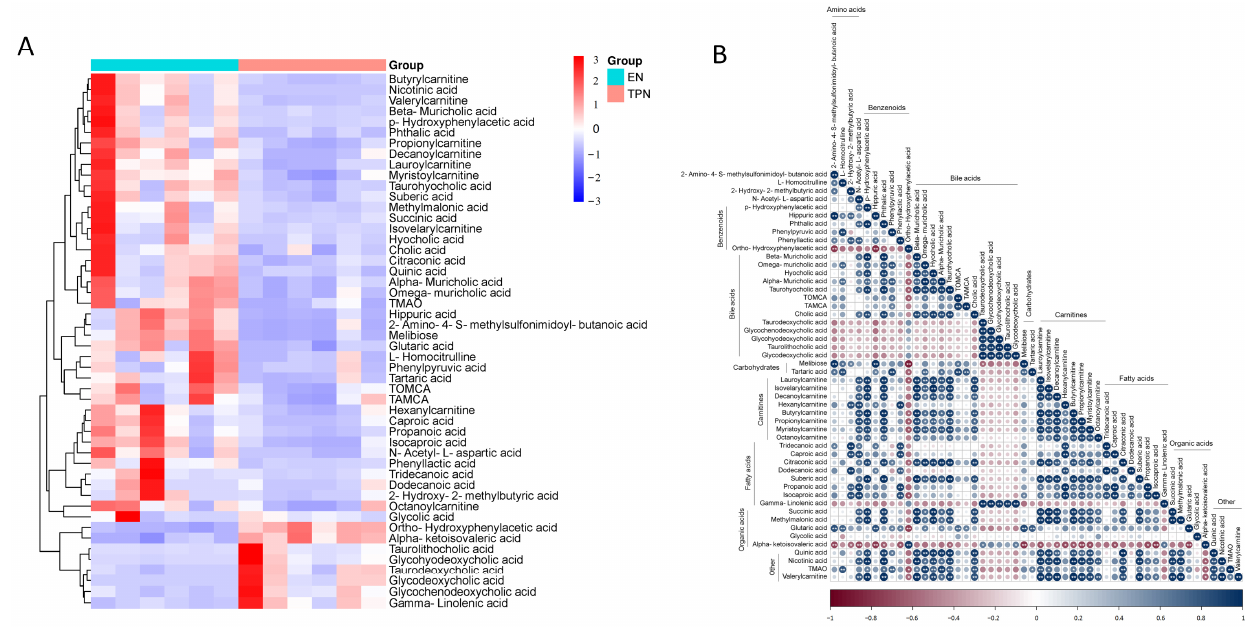
Figure 2. Top 50 differential metabolites between EN and TPN. ( A ) Hierarchical clustering of top 50 differential metabolites. ( B ) Correlation matrix of top 50 differential metabolites. Color indicates the value of correlation coefficient (* p < 0.05, ** p < 0.01).